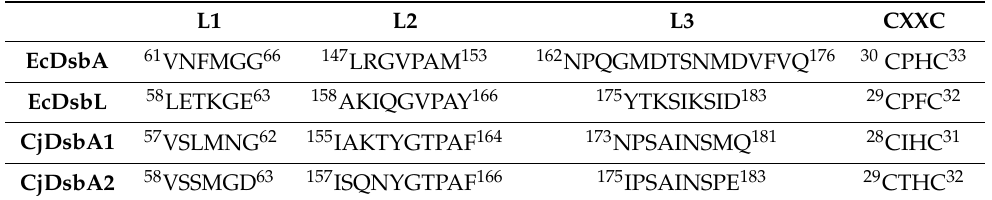
Table 3. Loops and catalytic motif sequences of C. jejuni and E. coli Dsb proteins.